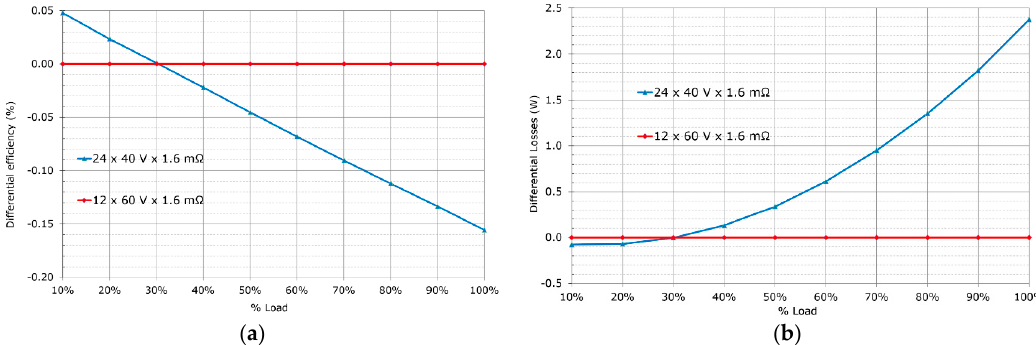
Figure 7. Performance comparison for different rectification stage configuration of equivalent R DS(on) . Full bridge rectification with 24 units of 40 V class devices in blue, and the center tapped with 12 units of 60 V class devices in red. ( a ) Differential efficiency; ( b ) differential losses.